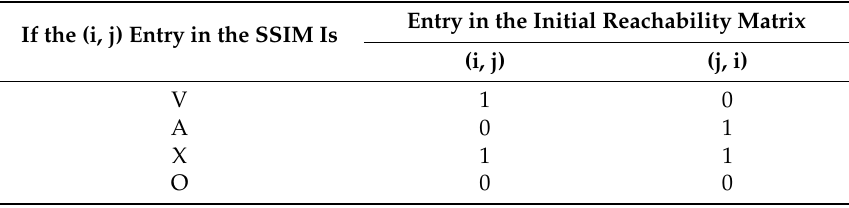
Table 2. Rules for